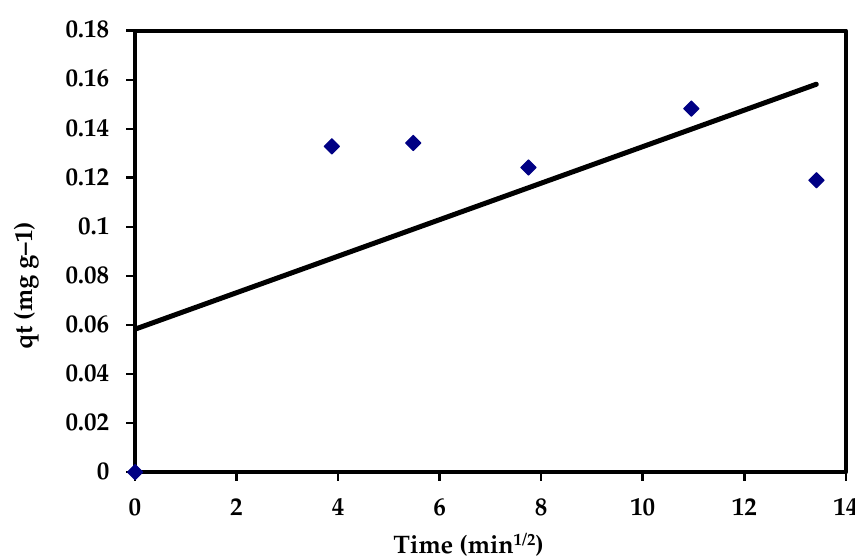
Figure 17. The intra-particle diffusion plots for the adsorption of CVD onto S. costatum .